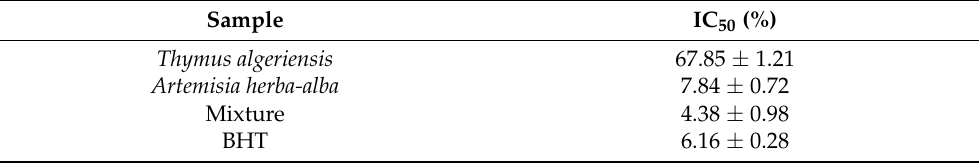
Values are expressed as the mean ± standard deviation ( n = 3).